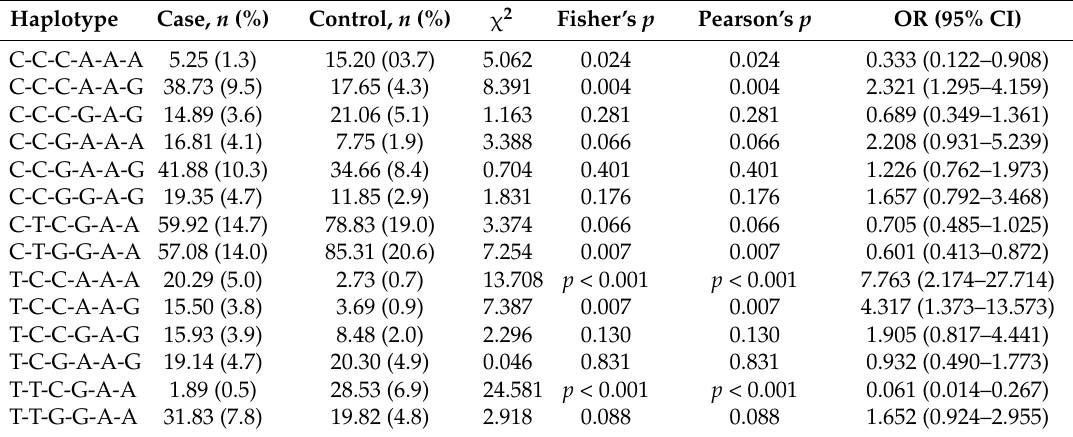
Table 6. Estimated haplotype frequencies of six SNPs in ABCA1 in individuals of the Kazakh nationality with low and normal HDL-C